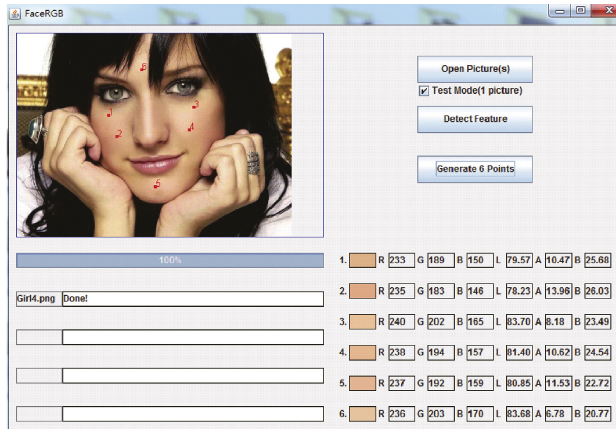
Figure 9: The result of FaceRGB from one